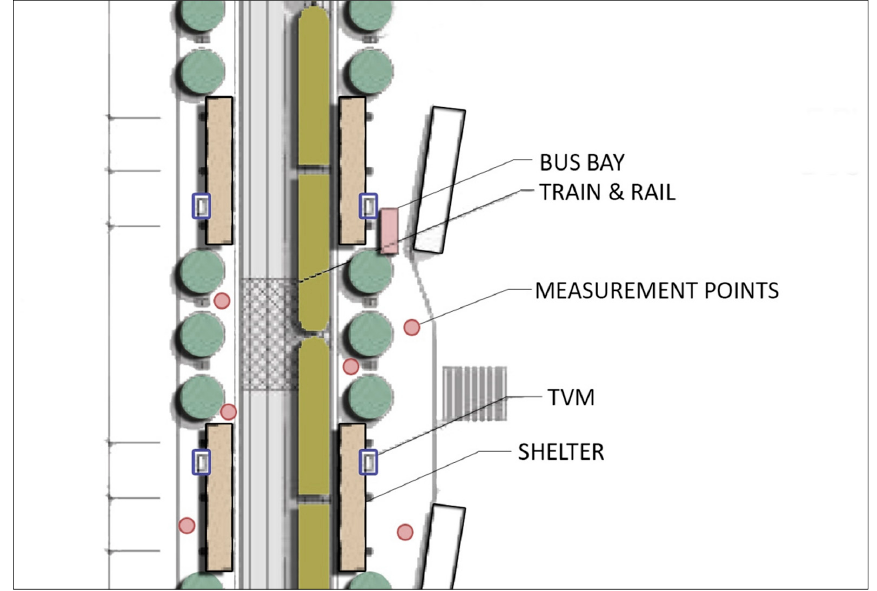
Figure 2. Sample sound measurement approach (Source: Dallas Area Rapid Transit (DART),